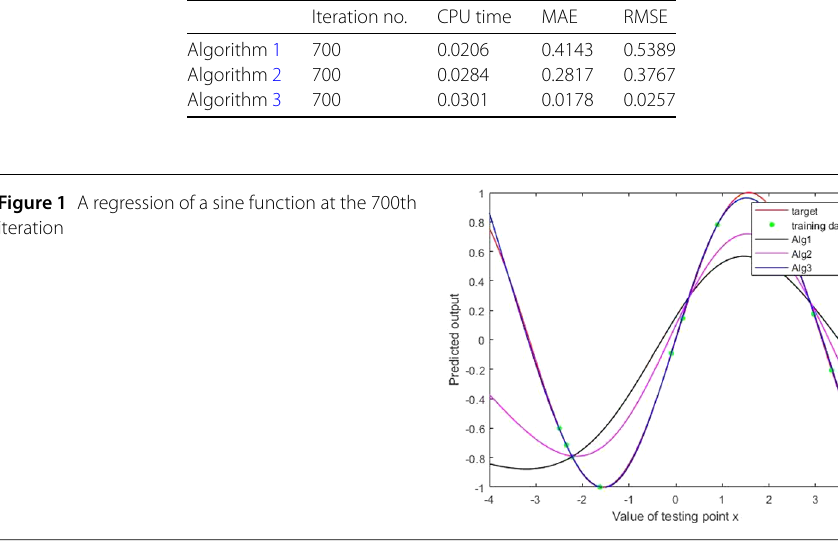
Table 4 Numerical results of a regression of a sine function at the 700th iteration Iteration no. CPU time